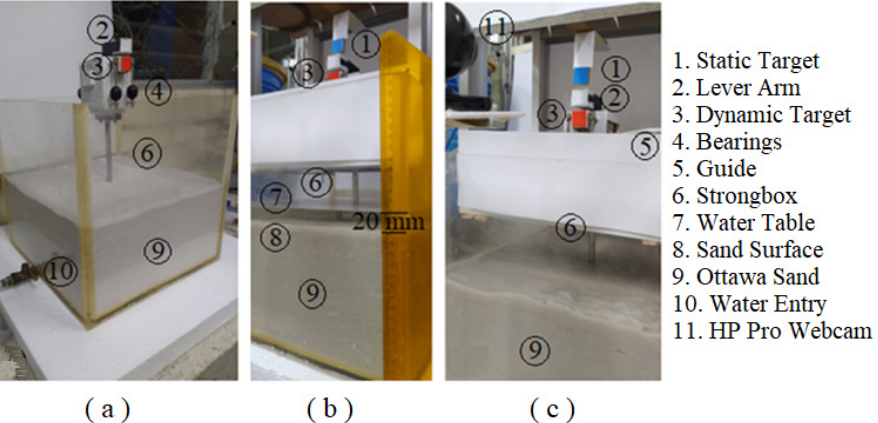
Figure 3. Saturation process: ( a ) bottom-up water filling and location of the electromechanical oscillator at the center of the sand surface; ( b ) water level 20 mm above the sand surface to guarantee saturation after 20 h; and ( c ) complete set-up and equipment ready to test. Table 3. Common initial conditions of the samples for all